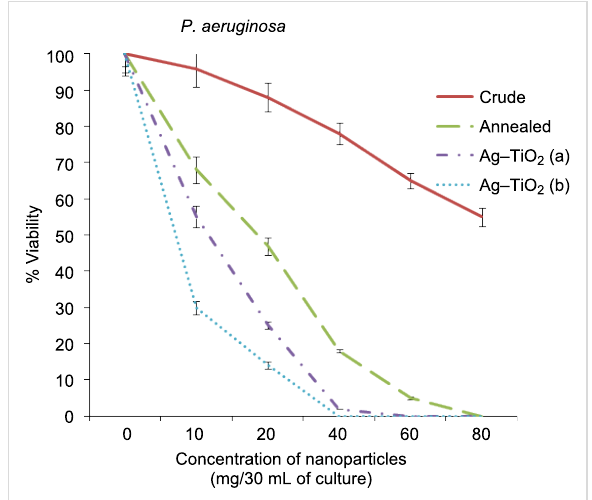
Figure 7: Viability of bacteria ( P. aeruginosa ) against the concentra- tion of nanoparticles (mg/30 mL of culture) in %.